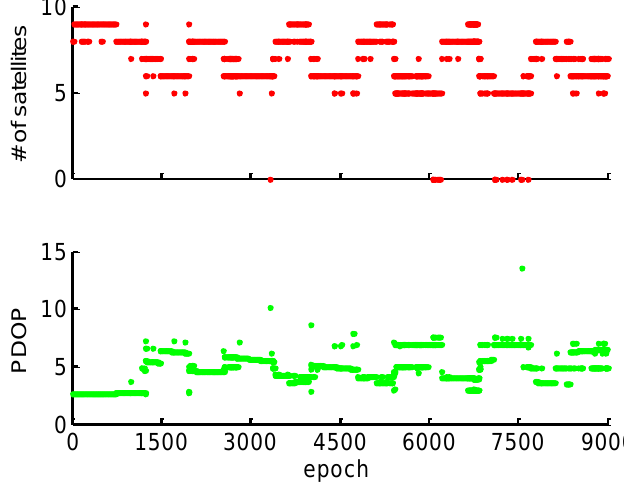
Figure 13. Available satellites and PDOP during the kinematic test.